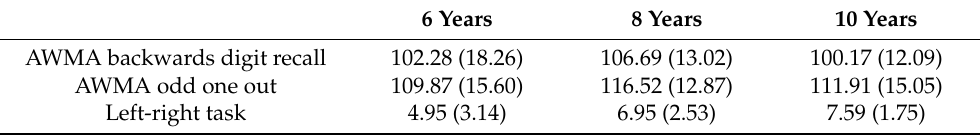
Table 1. Means and standard deviations (in brackets) for each age group on the experimental tasks.